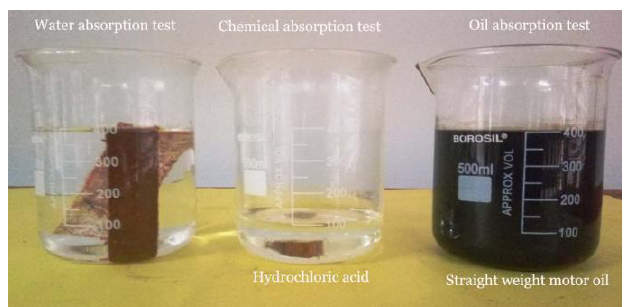
Fig. 2. Photographic image of Flexural, Tensile and Impact machine setup